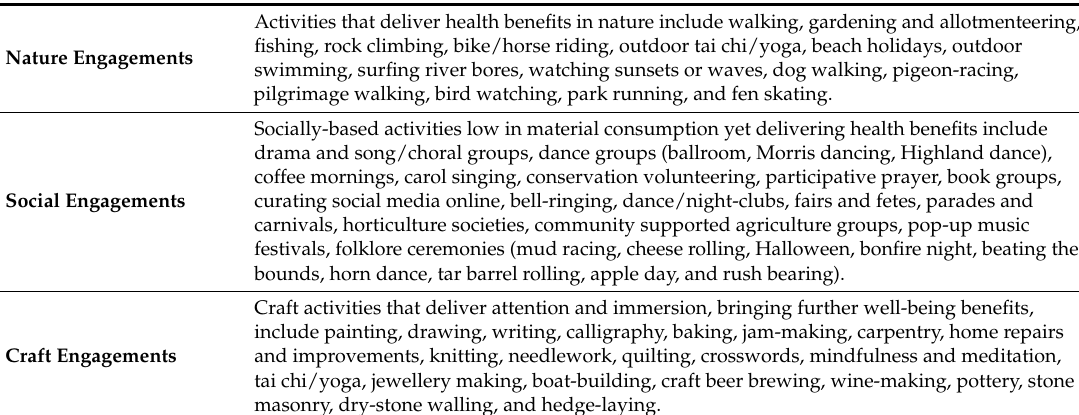
Table 3. Nature, social, and craft engagements that build the green